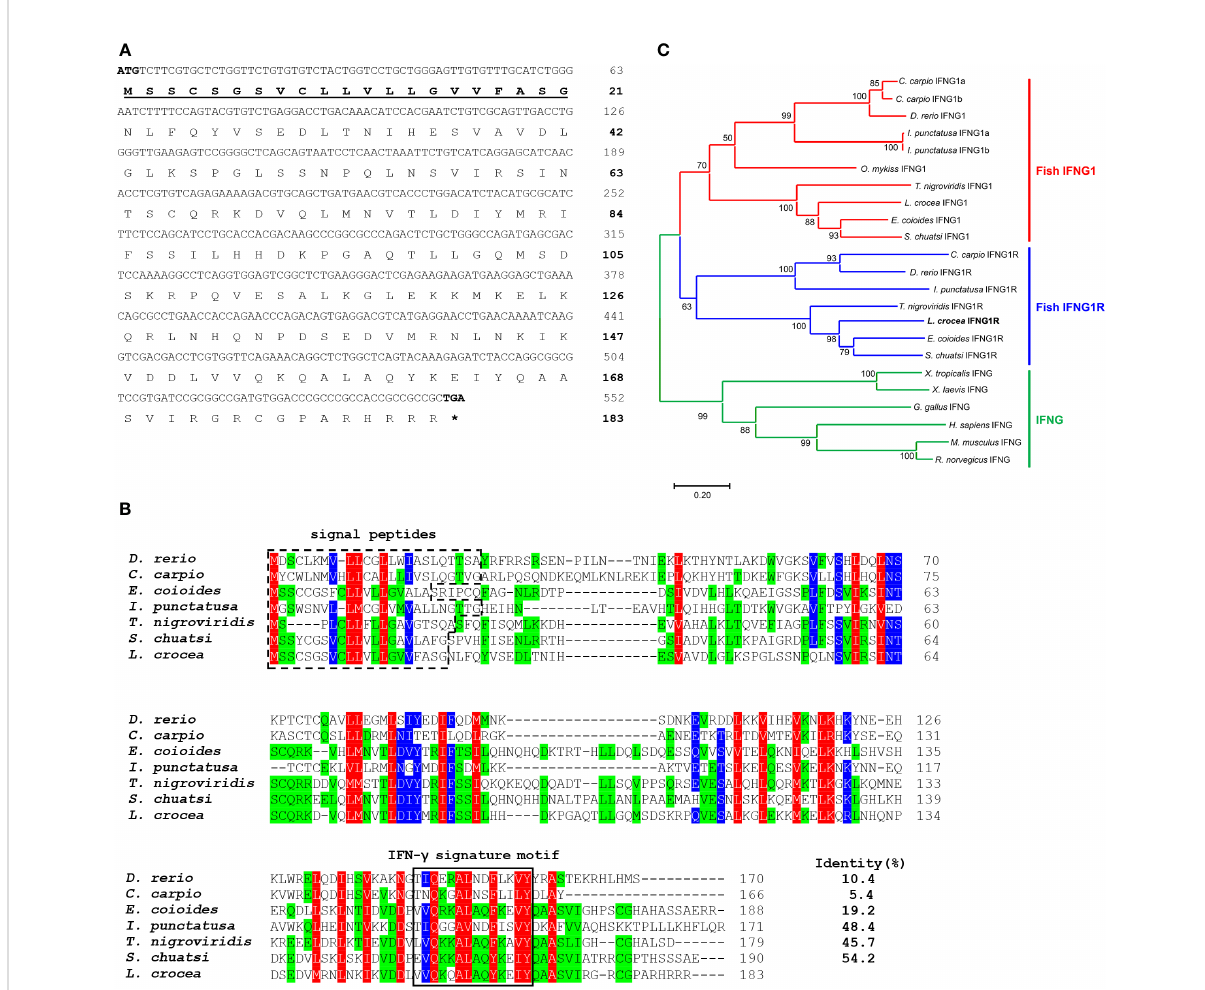
FIGURE 1 Sequence analysis of large yellow croaker IFNG1R molecule. (A) ORF and the deduced amino acid sequence of IFNG1R. The predicted signal peptides are in boldface and underlined. (B) Multiple sequence alignments of large yellow croaker IFNG1R with selected vertebrate IFNG1R. (C) An unrooted phylogenetic tree of vertebrate IFNG1R. Percentage values shown for each node represent 1000 bootstrap replications. In the multiple alignment and tree construction, GenBank accession numbers are as follows: human ( Homo sapiens ) IFNG, NP_000610.2; mouse ( Mus musculus ) IFNG, NP_032363.1; rat ( Rattus norvegicus ) IFNG, NP_620235.1; chicken ( Gallus gallus ) IFNG, NP_990480.1; African clawed frog ( Xenopus laevis ) IFNG, XP_018110090.1; tropical clawed frog ( Xenopus tropicalis ) IFNG, XP_002938555.1; zebra fi sh ( Danio rerio ) IFNG1, NP_998029.1; IFNG1R, BAD72865.1; common carp ( Cyprinus carpio ) IFNG1a, CAJ51088.1; IFNG1b, CAJ51089.1; IFNG1R, CAJ98867.1; orange- spotted grouper ( Epinephelus coioides ) IFNG1, AFM31242.1; IFNG1R, QEA72089.1; channel cat fi sh ( Ictalurus punctatus ) IFNG1a, AAZ40505.1; IFNG1b, AAZ40506.1; IFNG1R, AAZ40504.1; spotted green puffer fi sh ( Tetraodon nigroviridis ) IFNG1, AHZ62714.1; IFNG1R, AHZ62713.1; mandarin fi sh ( Siniperca chuatsi ) IFNG1, QDO15115.1; IFNG1R, QDO15116.1; rainbow trout ( Oncorhynchus mykiss ) IFNG1, CAE82300.1; large